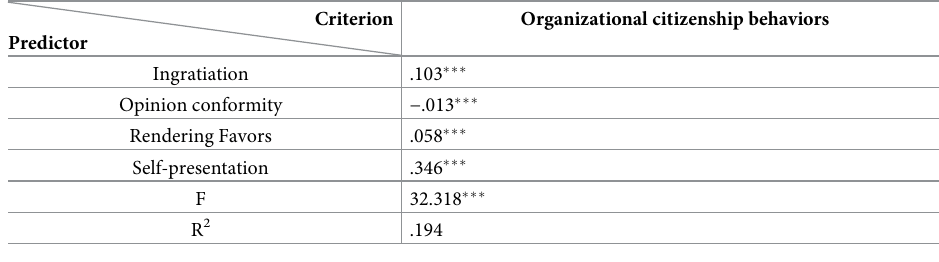
Table 3. Regression analysis of impression management and organizational citizenship